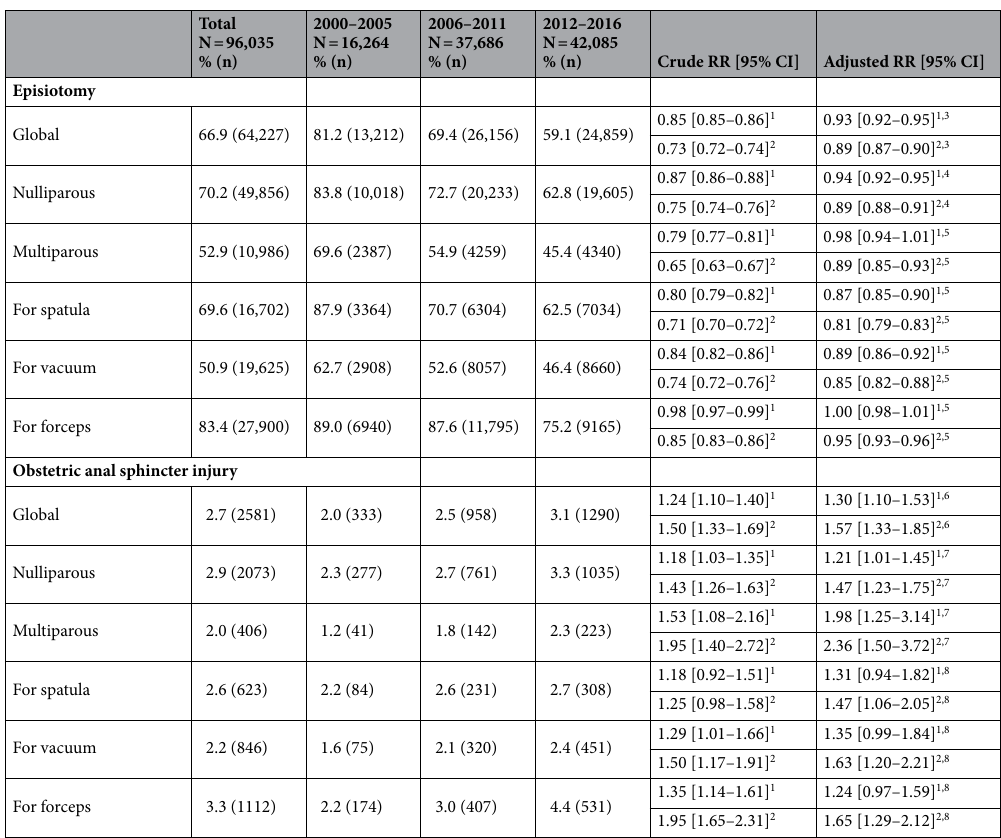
Table 3. Episiotomy and obstetric anal sphincter injury rates in the overall cohort and according to 3 studied periods. 1 RR: 2006–2011 vs. 2000–2005. 2 RR: 2012–2016 vs. 2000–2005. 3 RR adjusted for: geographical origin (France or Southern Europe or North Africa or other origin vs. Asia vs. Africa), BMI (< 25 vs. ≥ 25), parity (nulliparous vs multiparous), instrumental delivery type (vacuum vs. forceps, vs. spatulas), percentile birthweight (≤ 90 vs. > 90), head circumference (< 36 cm vs. ≥ 36 cm) and level of maternity ward (I vs. II, vs. III). 4 RR adjusted for: adjusted for: geographical origin (France or Southern Europe or North Africa or other origin vs. Asia vs. Africa), BMI (< 25 vs. ≥ 25), instrumental delivery type (vacuum vs. forceps, vs. spatulas), percentile birthweight (≤ 90 vs. > 90), head circumference (< 36 cm vs. ≥ 36 cm) and level of maternity ward (I vs. II, vs. III). 5 RR adjusted for: geographical origin (France or Southern Europe or North Africa or other origin vs. Asia vs. Africa), BMI (< 25 vs. ≥ 25), parity (nulliparous vs multiparous), percentile birthweight (≤ 90 vs. > 90), head circumference (< 36 cm vs. ≥ 36 cm) and level of maternity ward (I vs. II, vs. III). 6 RR adjusted for: geographical origin (France or Southern Europe or North Africa or other origin vs. Asia vs. Africa), BMI (< 25 vs. ≥ 25), parity (nulliparous vs multiparous), instrumental delivery type (vacuum vs. forceps, vs. spatulas), episiotomy (yes, no), percentile birthweight (≤ 90 vs. > 90), head circumference (< 36 cm vs. ≥ 36 cm) and level of maternity ward (I vs. II, vs. III). 7 RR adjusted for: adjusted for: geographical origin (France or Southern Europe or North Africa or other origin vs. Asia vs. Africa), BMI (< 25 vs. ≥ 25), instrumental delivery type (vacuum vs. forceps, vs. spatulas), episiotomy (yes, no), percentile birthweight (≤ 90 vs. > 90), head circumference (< 36 cm vs. ≥ 36 cm) and level of maternity ward (I vs. II, vs. III). 8 RR adjusted for: geographical origin (France or Southern Europe or North Africa or other origin vs. Asia vs. Africa), BMI (< 25 vs. ≥ 25), parity (nulliparous vs multiparous), episiotomy (yes, no), percentile birthweight (≤ 90 vs. > 90), head circumference (< 36 cm vs. ≥ 36 cm) and level of maternity ward (I vs. II, vs.